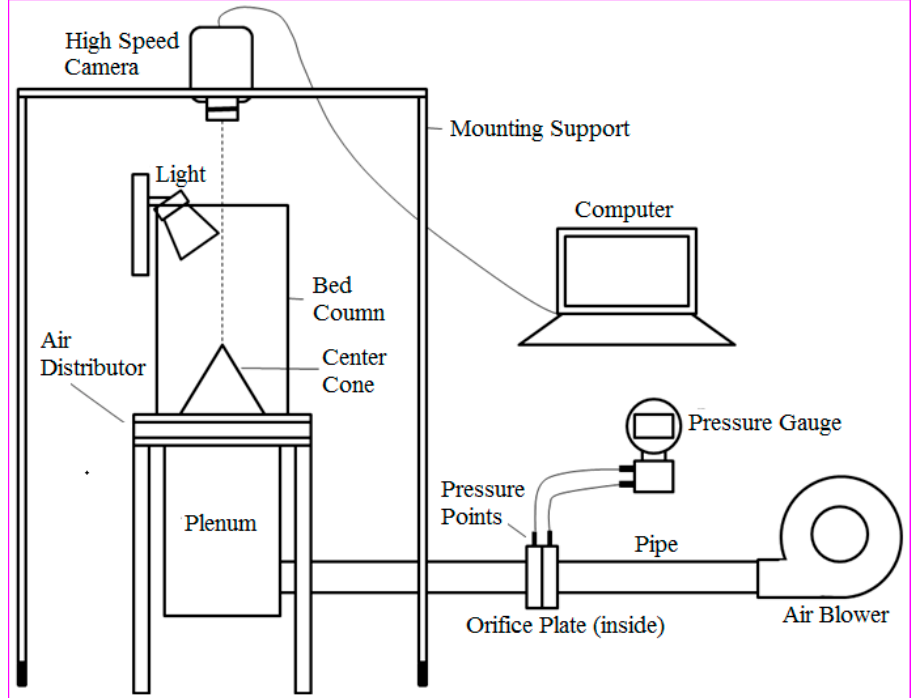
Figure 3. The experimental rig consisted of a swirling fluidized bed (SFB), a high-speed camera and a data acquisition setup.